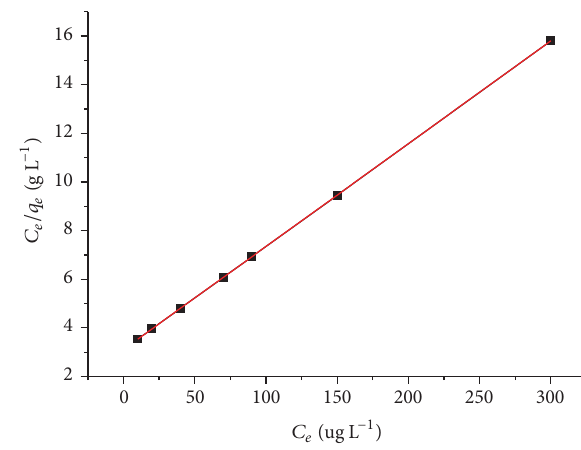
Figure 9: Langmuir isotherm plot of Fe 3 O 4 @MIP adsorption to